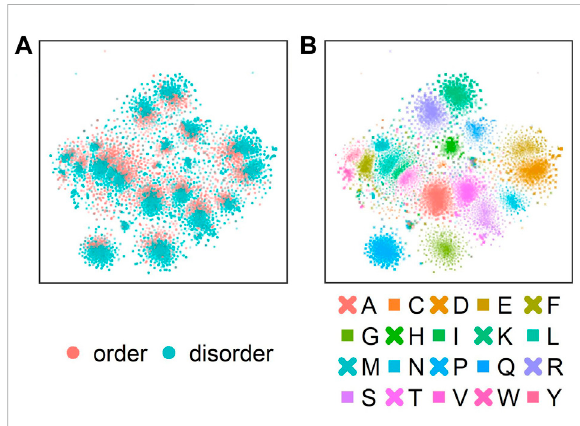
FIGURE 2 t-SNE dimensionality reduction (van der Maaten and Hinton, 2008) performed on the 1024-dimensional ProtT5 (Elnaggar et al., 2021) residue-level embeddings extracted from the last attention layer of ProtT5 for all sequences in test set CheZOD117 [13,069 residues; (Dass et al., 2020)]. (A) shows the embeddings colored by order (CheZOD score > 8; red) and disorder [CheZOD score ≤ 8, blue; (Nielsen and Mulder, 2016)]. (B) shows the same t-SNE projection but with coloring by the 20 standard amino acid types (here shown in one-letter code; A = Alanine, C=Cysteine, D=Asparticacid,E=Glutamicacid,F=Phenylalanine,G=Glycine,